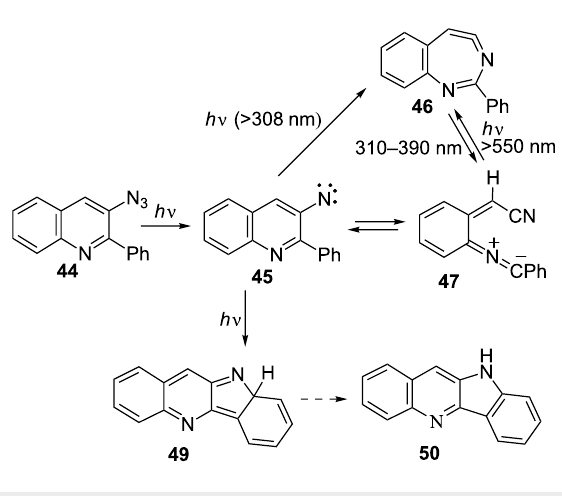
Scheme 11: Photolysis of 3-azido-2-phenylquinoline.